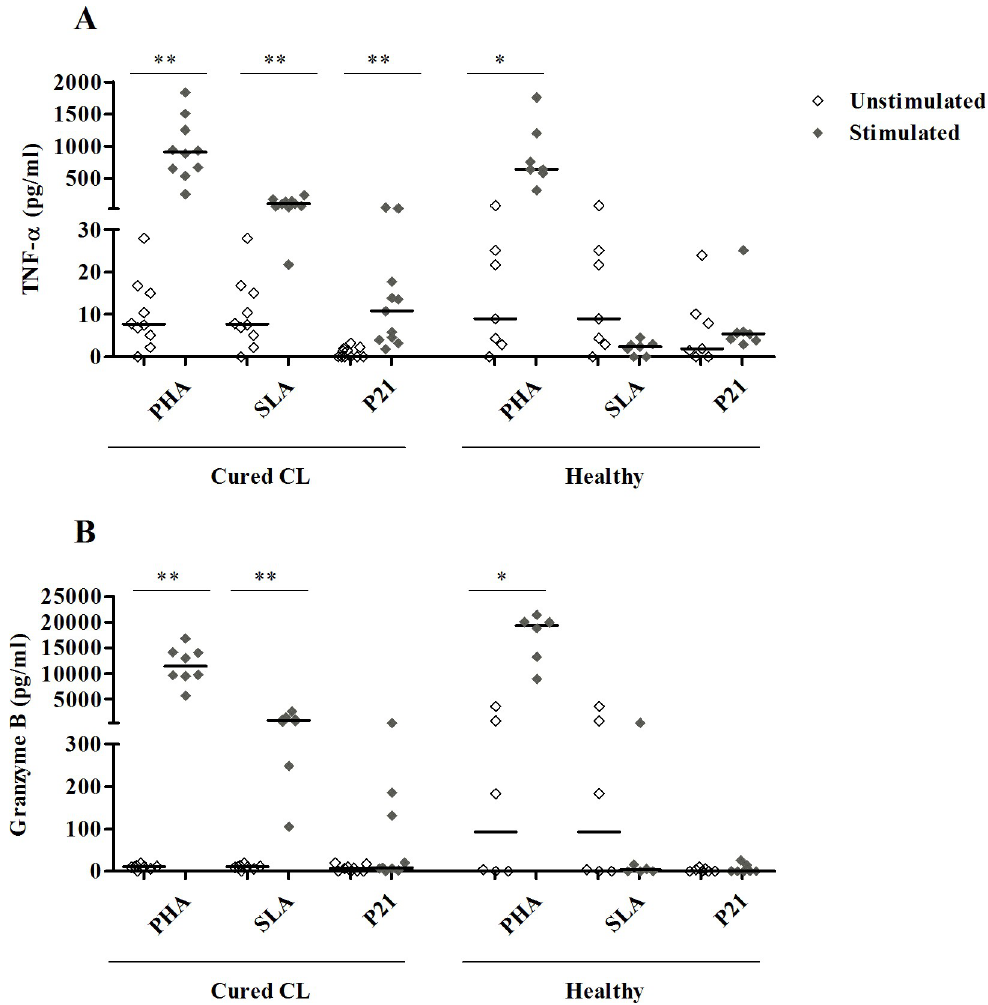
Fig 6. TNF- α and Granzyme B responses to P21 peptide pool. TNF- α (A) and GrB (B) were quantified by CBA, in the culture supernatants of PBMC from cured subjects (N = 11) or healthy individuals (N = 7) stimulated with P21 (1 μ M), for 10 days. PHA and SLA (10 μ g/ml) were used as positive controls. Horizontal bars indicate median values. Statistical significance was assigned to a value of p < 0,05 ( � p < 0.05, �� p <